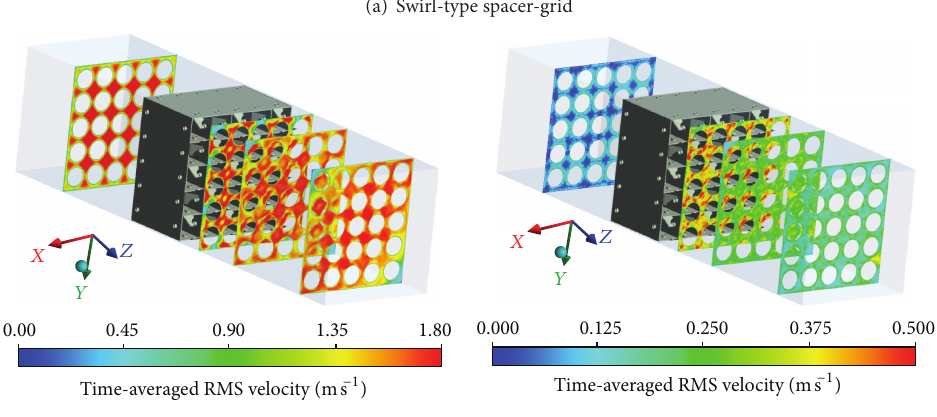
as the one used in this paper was satisfactory predicting the turbulent results. The simplifications added in the mod- eling stage reduce the simulation time substantially and allow a LES simulation with the performance of a regular